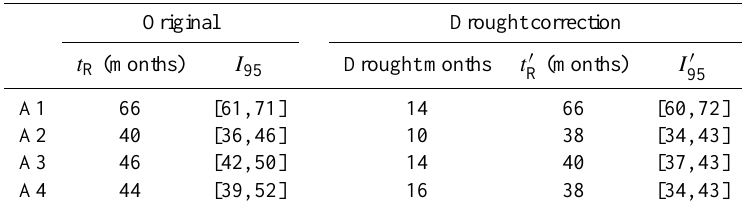
Table 1. Vegetation recovery time ( t R ) and respective 95% confidence interval ( I 95 ) , as estimated by the mono-parametric vegetation recovery model for the burnt scars in 2003. Period corresponding to drought as estimated by the analysis of NDVI anomaly on the surrounding ) and 95% confidence interval ( I 0 area of each scar. Vegetation recovery time ( t 0 ), as estimated by the mono-parametric vegetation recovery R 95 model after setting the values of y corresponding to the drought period as missing data.